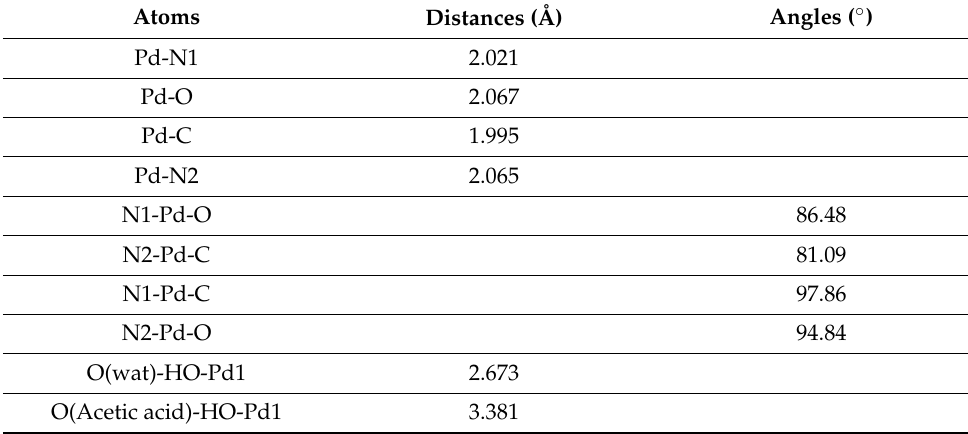
Table 3. Table of selected bond angles and distances around Pd(II) for